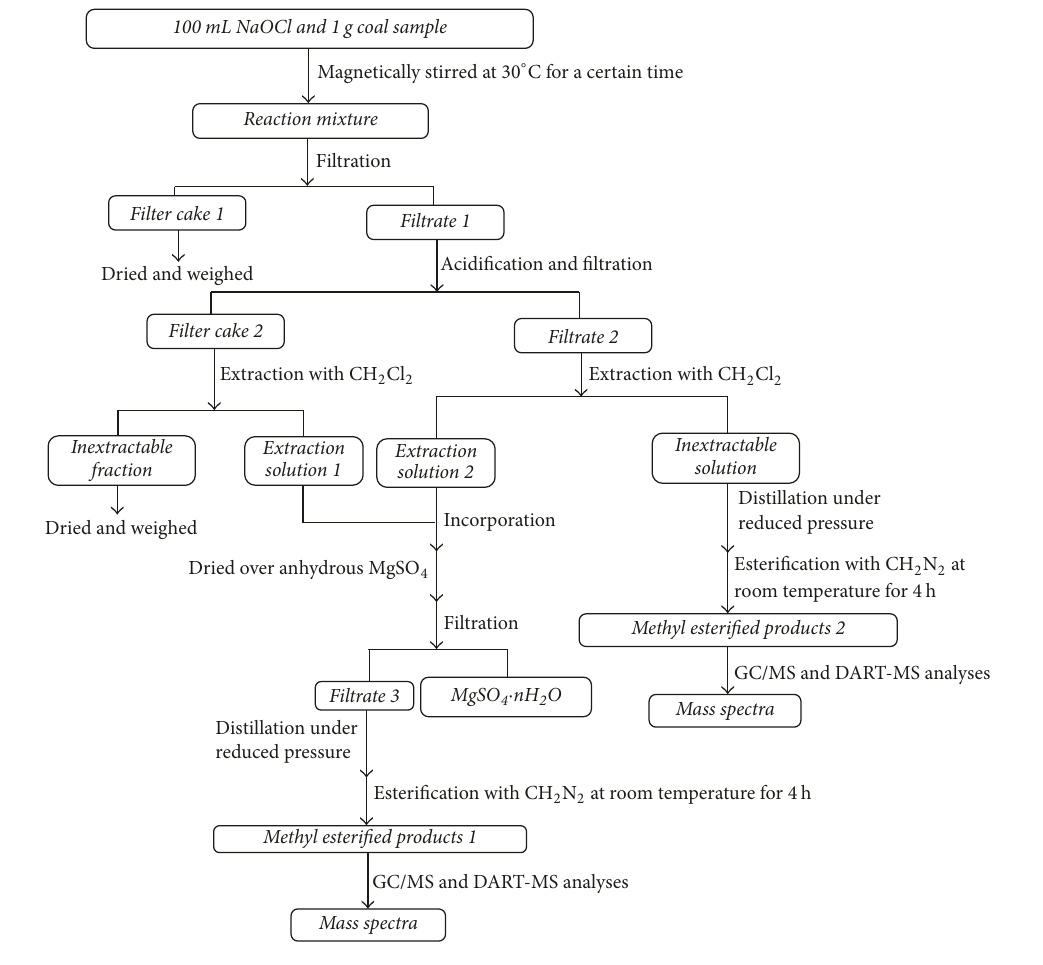
Figure 1: Experimental procedure and analytical methods.